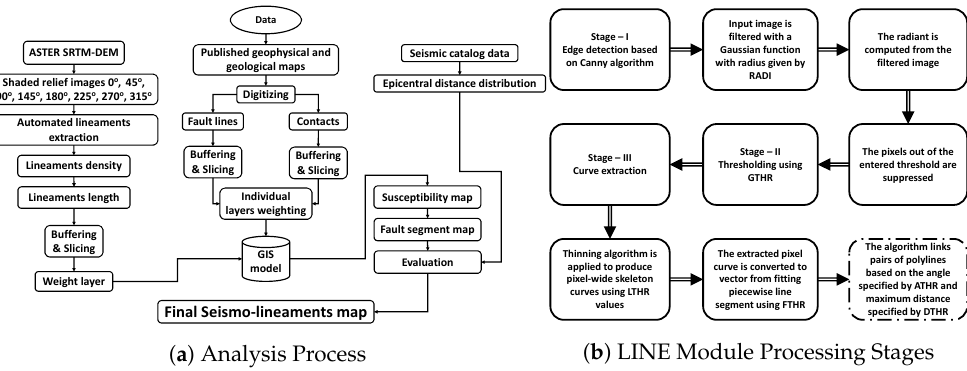
Figure 3. ( a ) The adopted analysis process in this study. ( b ) The LINE module’s processing flow